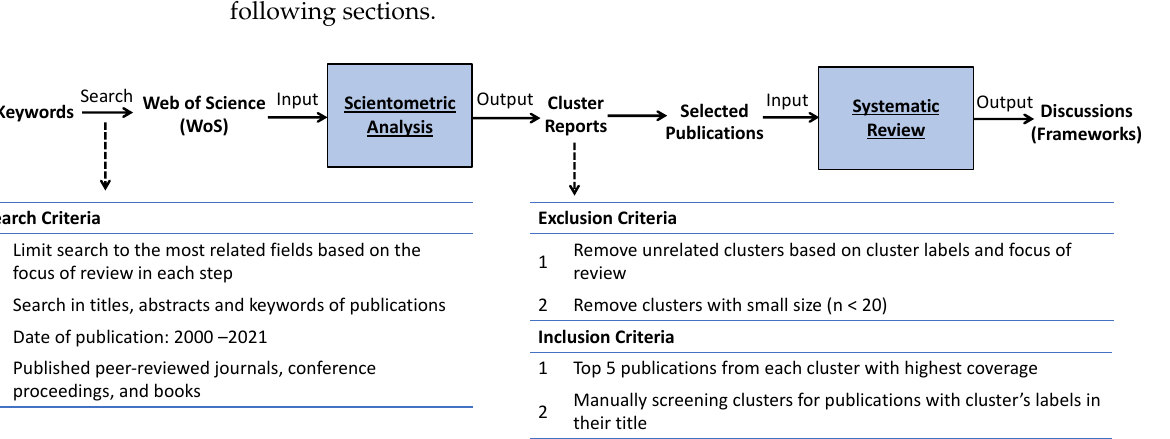
Figure 2. Relationship between scientometric analysis and systematic review including search, exclusion, and inclusion criteria.